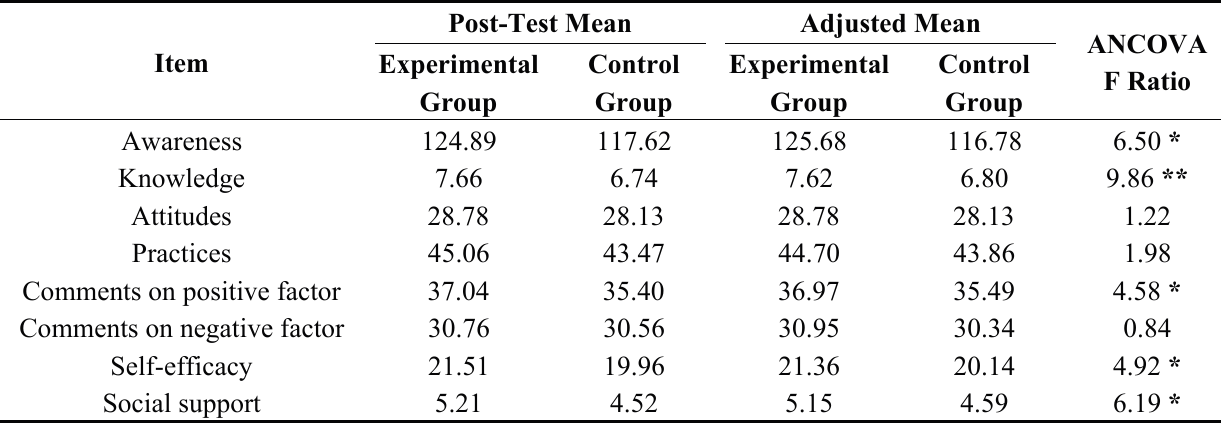
Table 4. Research subjects’ post-test on prevention of occupational